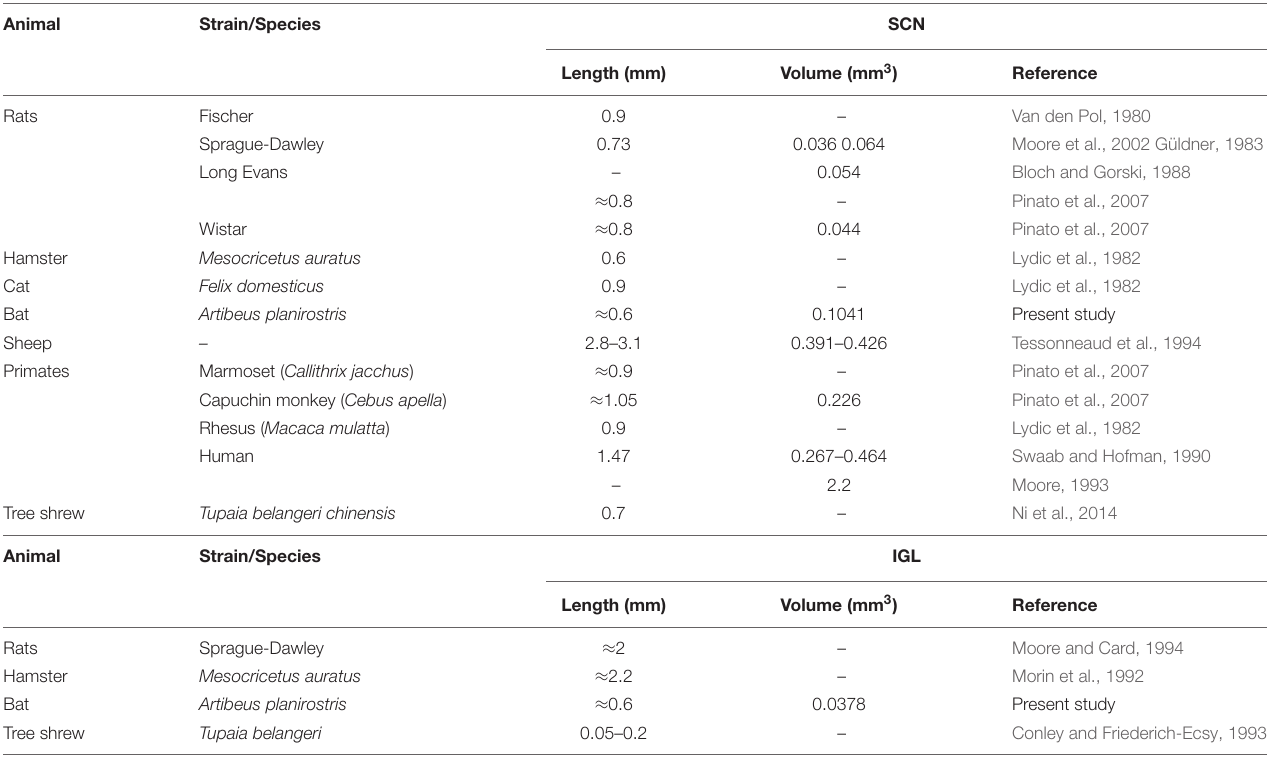
TABLE 2 | Comparative analysis of morphometric and stereological aspects of the SCN and IGL from mammalians. Animal Strain/Species